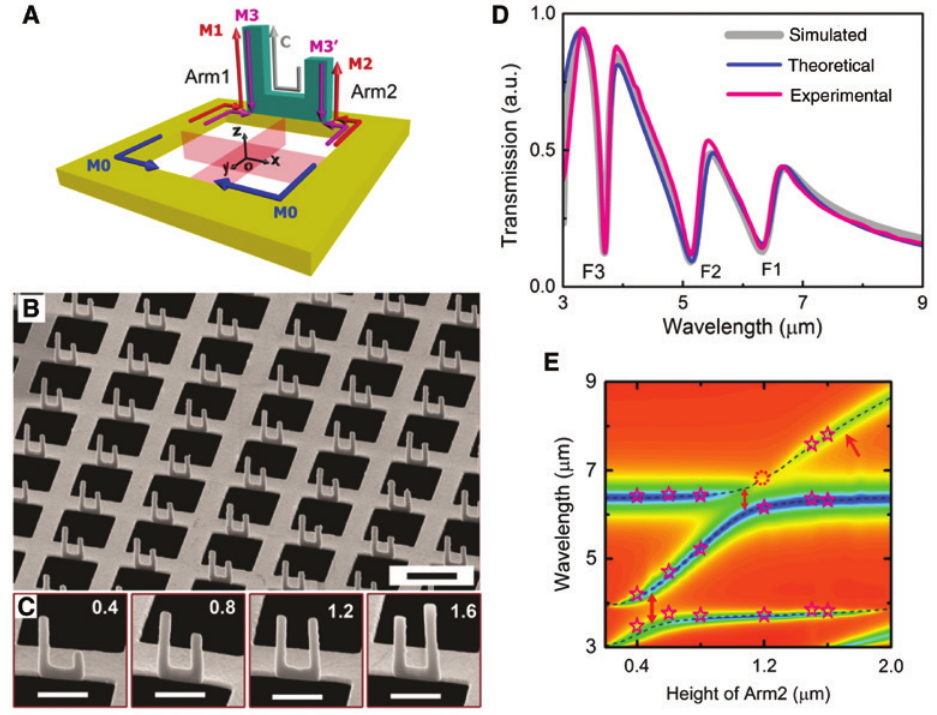
Figure 8: Strong interactions among triple Fano resonances [37]. (A) Schematic of the unit cell of a 3D nanostructure, which consists of a vertical asymmetric SRR (aSRR) standing along one edge of a metallic hole. The arrows in different colors indicate different types of current oscillations existing within the unit cell, which correspond to one bright mode (M0) and three dark modes (M1, M2, and M3/M3’). The mode M0 interacts with modes M1, M2, and M3, respectively, which results in the triple Fano resonances F1, F2, and F3 in (D). (B, C) SEM images of aSRRs with different arm lengths standing along one edge of metallic holes. (D) Simulated, theoretical, and experimental transmission spectra of the array in (B), which show excellent agreement. (E) Color map of the simulated absorption spectra of the aSRRs versus the height of Arm2. The dashed curves show the calculated wavelengths of Fano resonances, and the red stars correspond to the experimental measurements. Scale bars: 1 μ